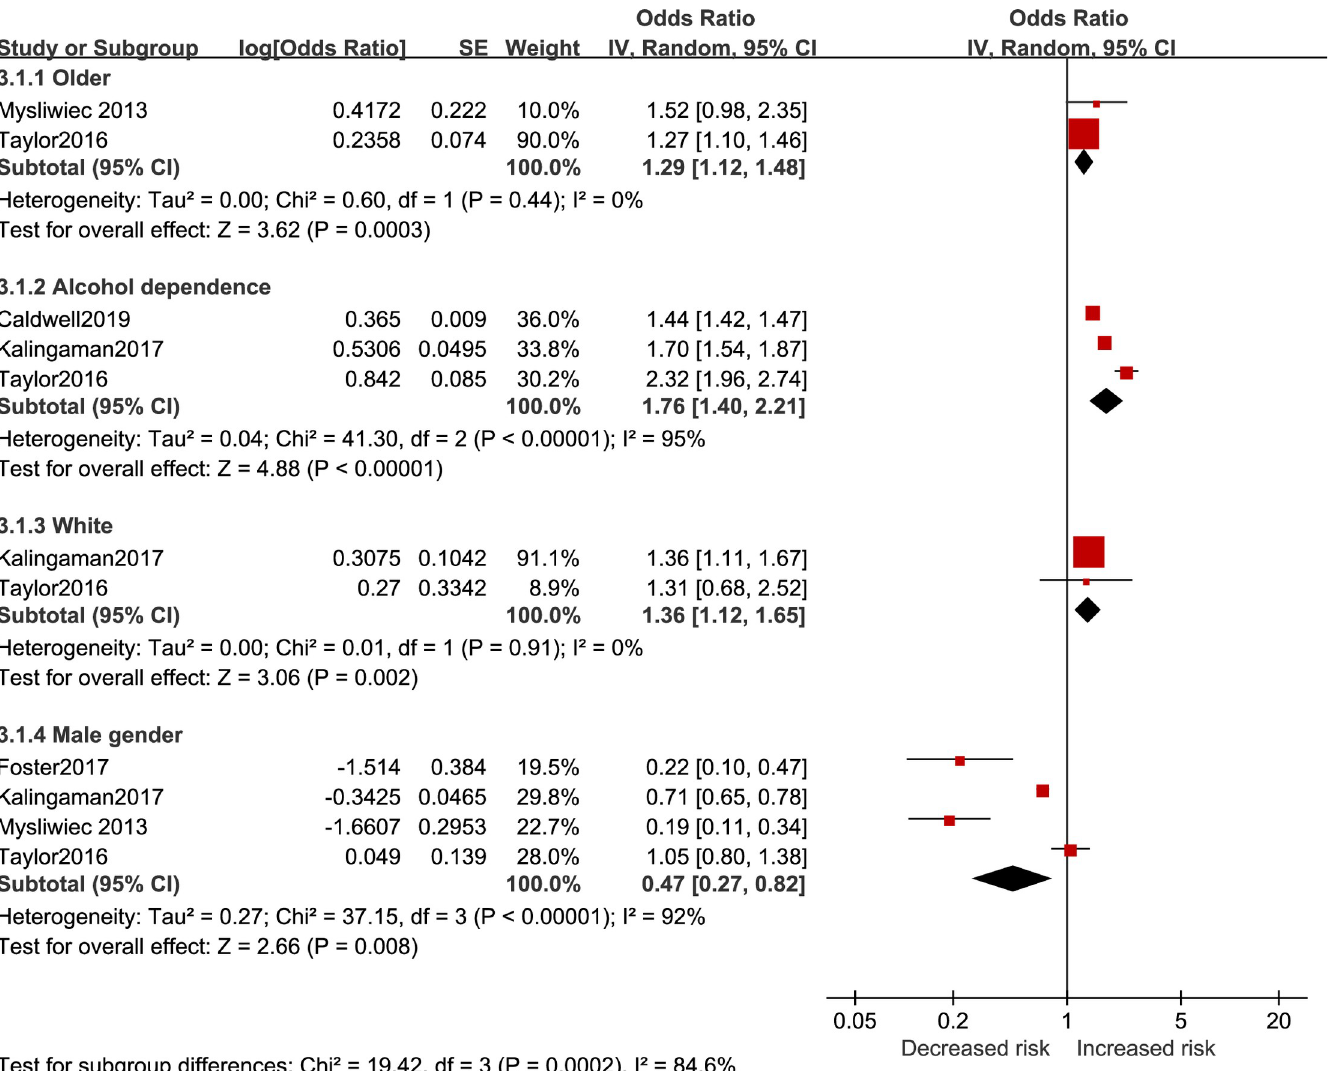
Fig 5. Sociodemographic factors for insomnia in active-duty